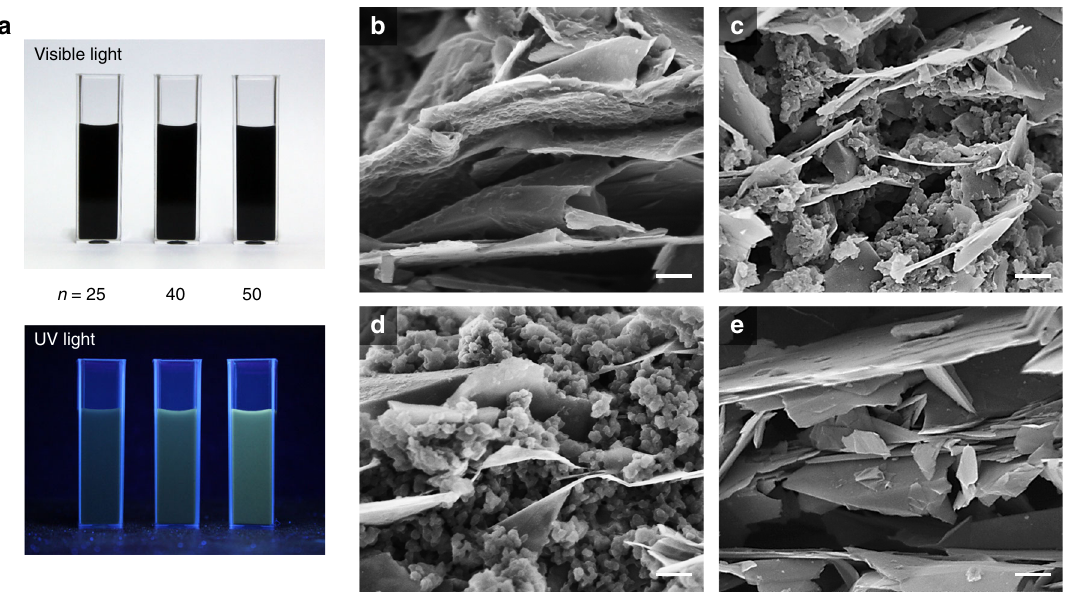
Fig. 2 Characterization of PGNHs. a Photographs showing the color changes of the P n GNH dispersions ( n = 25, 40, and 50) under visible and UV light illumination. b – e SEM images of P n GNHs with b n = 25, c n = 40, and d n = 50, and e control (graphene sheets alone). The scale bar is 200